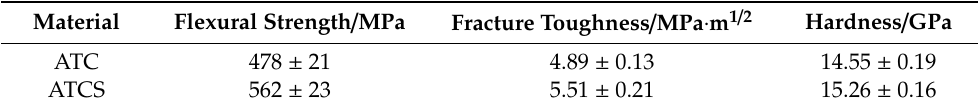
Table 1. Mechanical properties of the ceramic tool